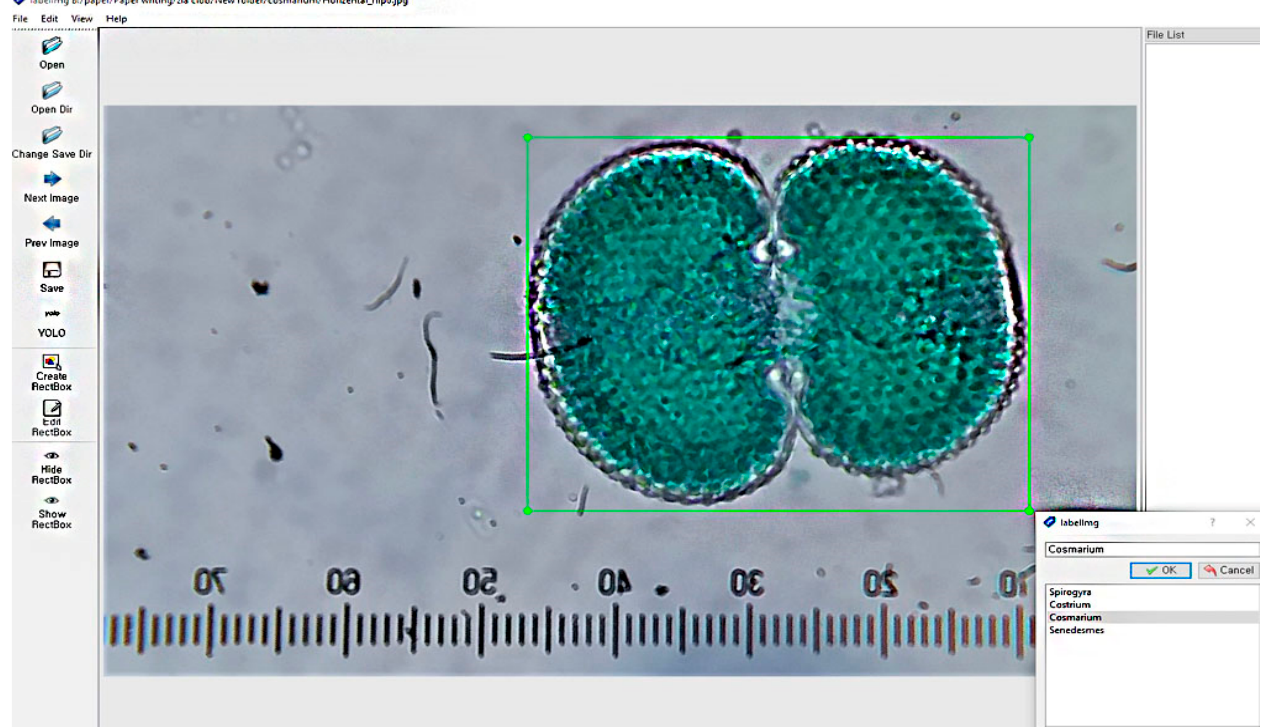
Figure 4. Annotation of images using the annotating tool.